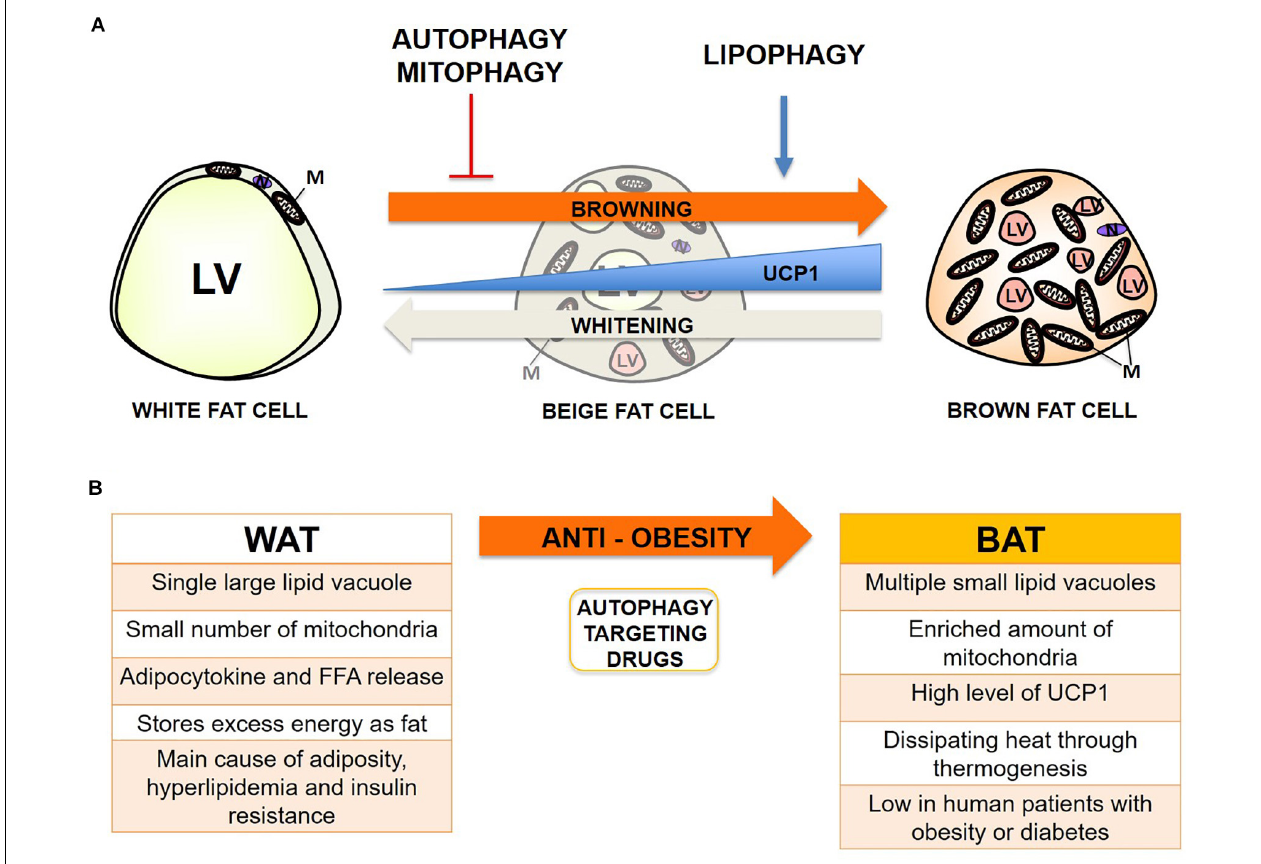
FIGURE 1 | Autophagy effect on adipocyte browning and potential therapeutic target for prevention of obesity. (A) Summary of the proposed effect of autophagy, lipophagy, and mitophagy on adipocyte browning from recent studies. LV, lipid vacuoles; M, mitochondria; N, Nucleus. (B) Summary of the main characteristics of WAT and BAT in obesity, and the induction of browning through manipulation of autophagy as a promising target for anti-obesity therapy.